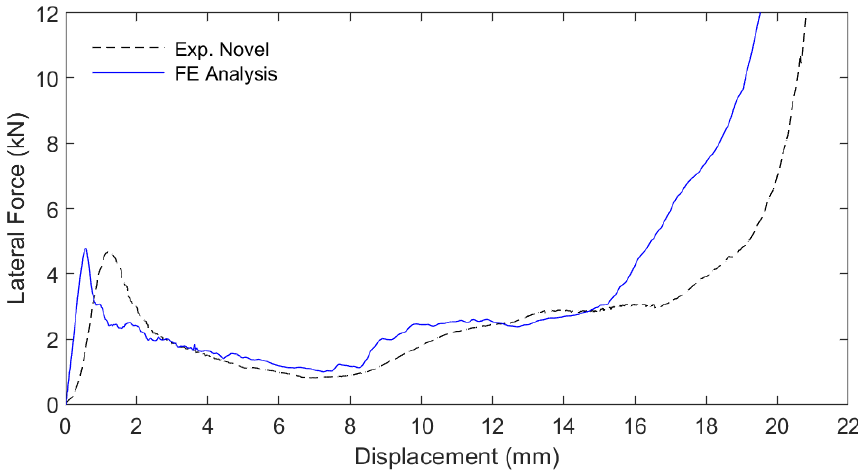
Figure 14. Shear stress concentration at the mid-section of the novel cell.